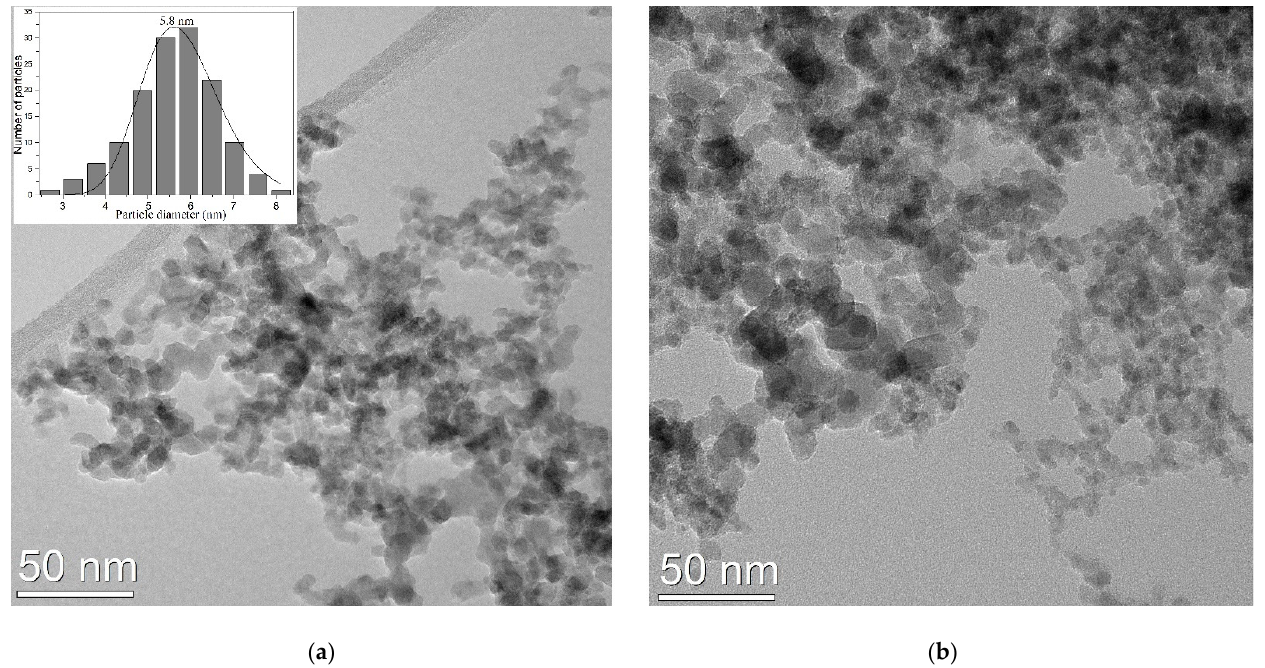
Figure 4. TEM images of the NPs ( a ) as synthesized nanoparticles ( b ) aggregates of NPs functionalised with TPPS. As it can be seen from the presented HR-TEM image, (Figure 5a) the functionalized particles are spherical or polyhedral, the size of those identified here varying from 12 to 5 nm. The particles are mostly crystalline as monodomain and the observed interplanar distances can be ascribed to the (220) and (311) planes of γ Fe 2 O 3 / Fe 3 O 4 at 0.29 nm (2.96 Å) and 0.25 nm (2.52 Å) respectively. From both microscopes, NPs covered grids EDS analyzes were performed in different places where the NPs agglomerates are not attached to the original amorphous carbon layer of the TEM grids. Qualitatively the presence of O, Fe, and a minor contribution C was detected, all derived from NPs. The presence of S and the major contribution of C comes from the adsorbed pseudo-porphyrin whose molecules contain -SO 3 − groups. The other elements appear as an artefact from the grids (Cu) or sample manipulation (Si). The constant presence of sulphur peak in EDS spectra from different places of the grid and also an intensity ratio between Fe-K α and S-K α peaks between 25 to 35 was used by us as an instrument to optimize the preparation process for NPs functionalized suspension.